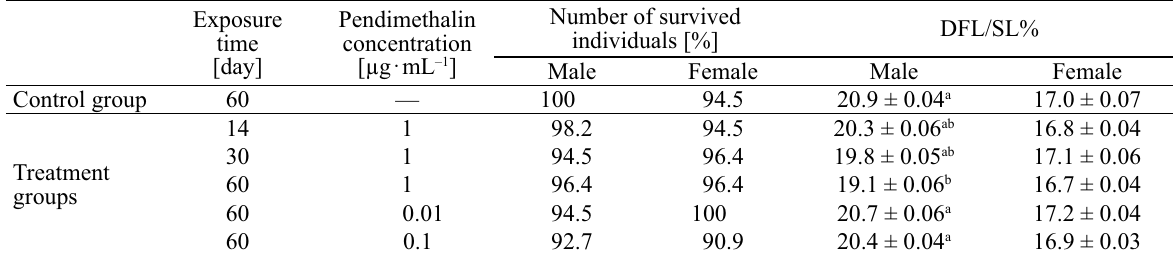
Effects of various exposure times and concentrations of pendimethalin on survival and dorsal fin